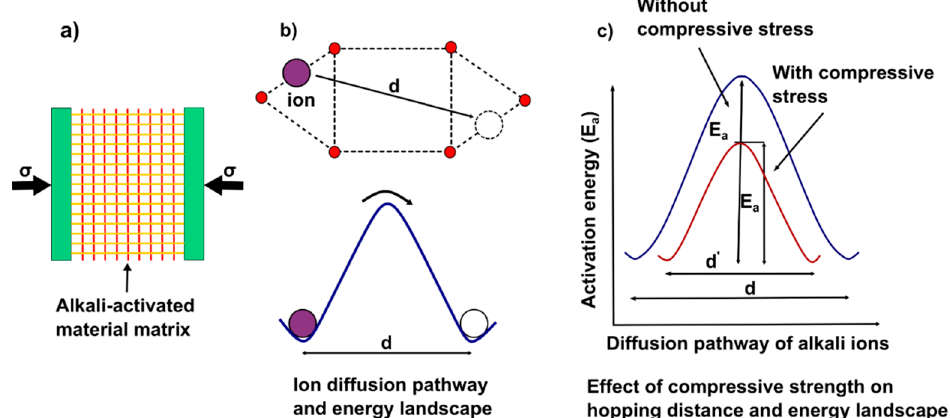
Figure 8. Self-sensing mechanism in AAM ( a ) AAM sensor under stress, ( b ) ion diffusion pathway in the matrix and energy landscape, ( c ) effect of the compressive stress on the activation energy and hopping distance d; adapted from [92].